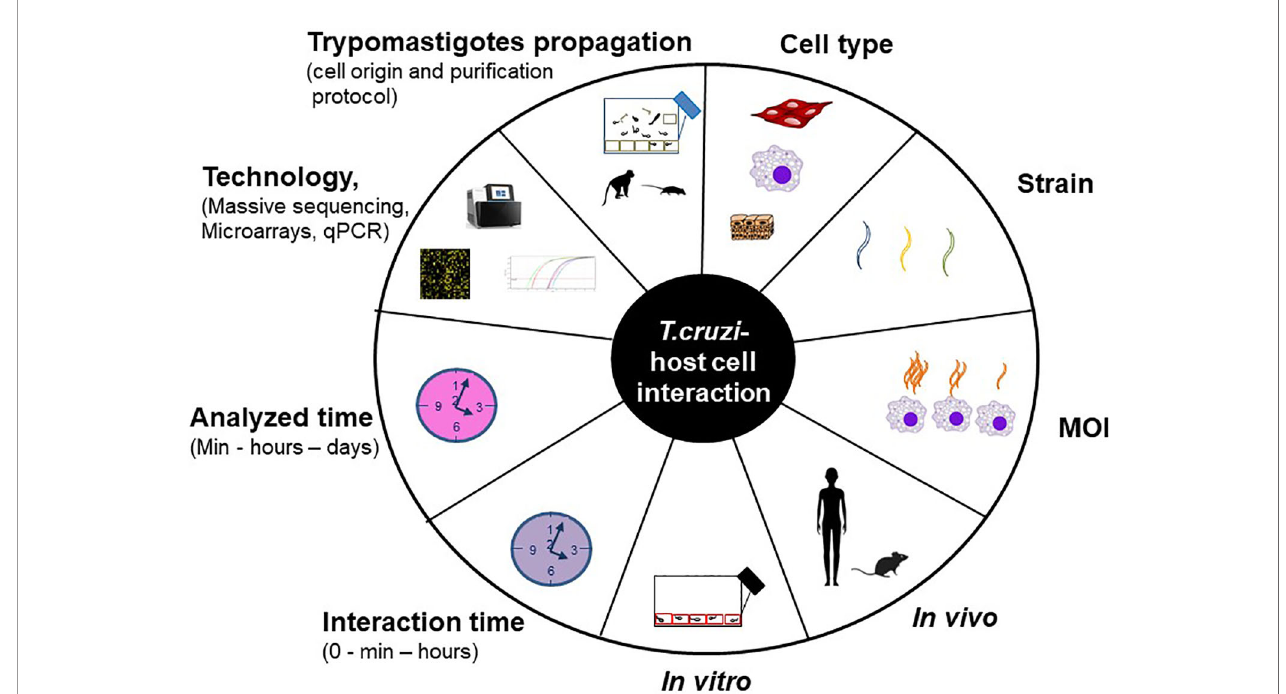
FIGURE 1 | Experimental variables that impact on T. cruzi – host cell interaction